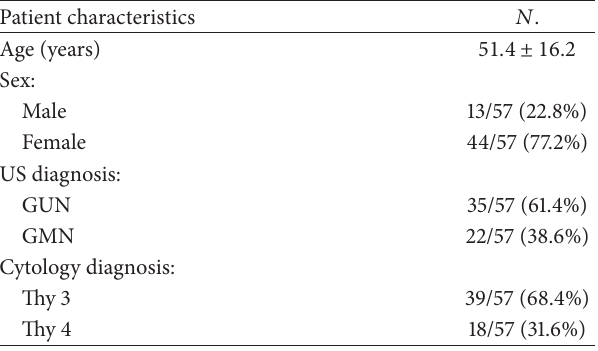
Table 1: Clinical and pathological characteristics. Patient